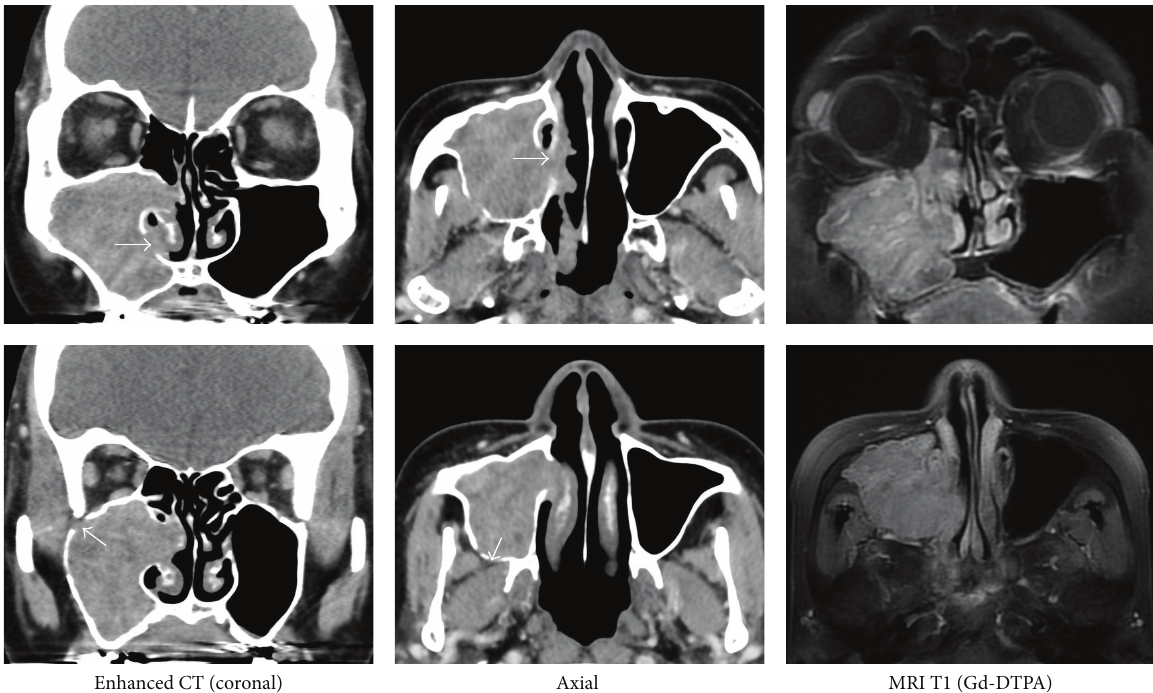
Figure 2: CT and MRI Imaging. The contrast CT shows bone defects in the anterior and medial walls of the maxillary sinus. There are no indications that the thickening of the bone should be suspected as the site of origin. MRI T1 (Gd-DTPA) shows secondary maxillary sinusitis and a serpentine cerebriform filamentous structure, but there is no mass to otherwise indicate a possible origin.